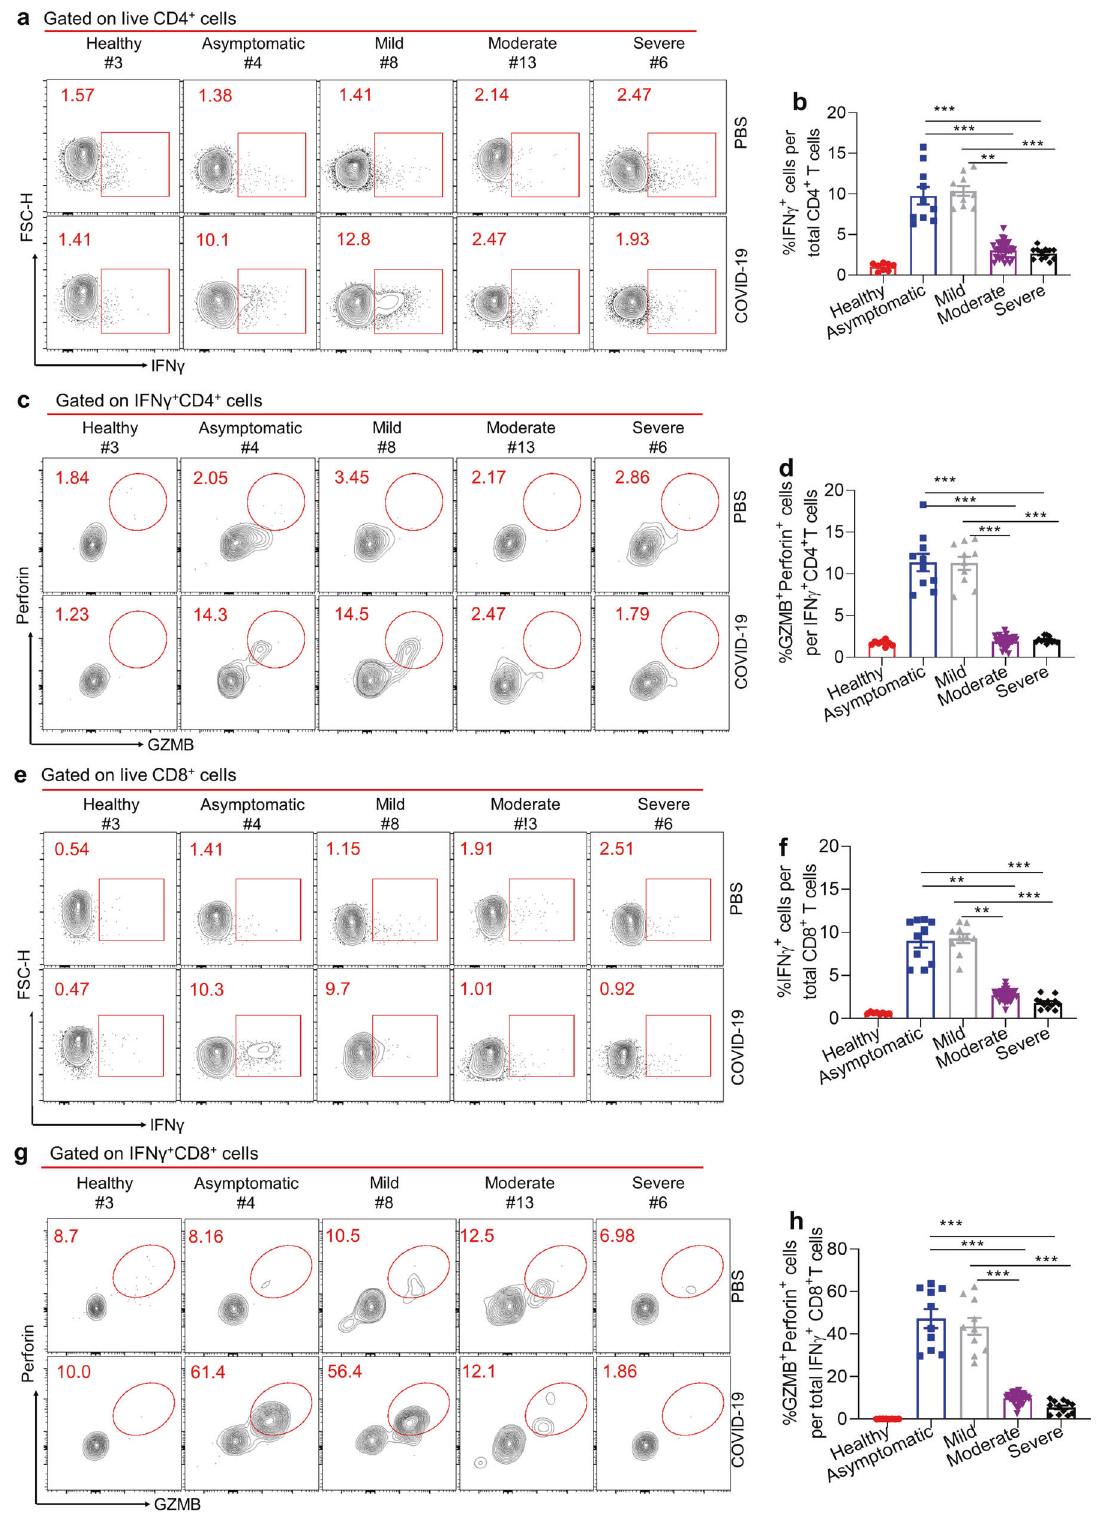
IFN- γ -secreting T H 1 cells in asymptomatic or mild symptomatic patients relative to healthy controls; however, in patients with moderate or severe symptoms, they only exhibited background levels of virus-speci fi c IFN- γ -producing T H 1 cells post antigen stimulation as healthy control (Fig. 4a, b). Moreover, among those IFN- γ -producing T H 1 cells, around 10% of them were found